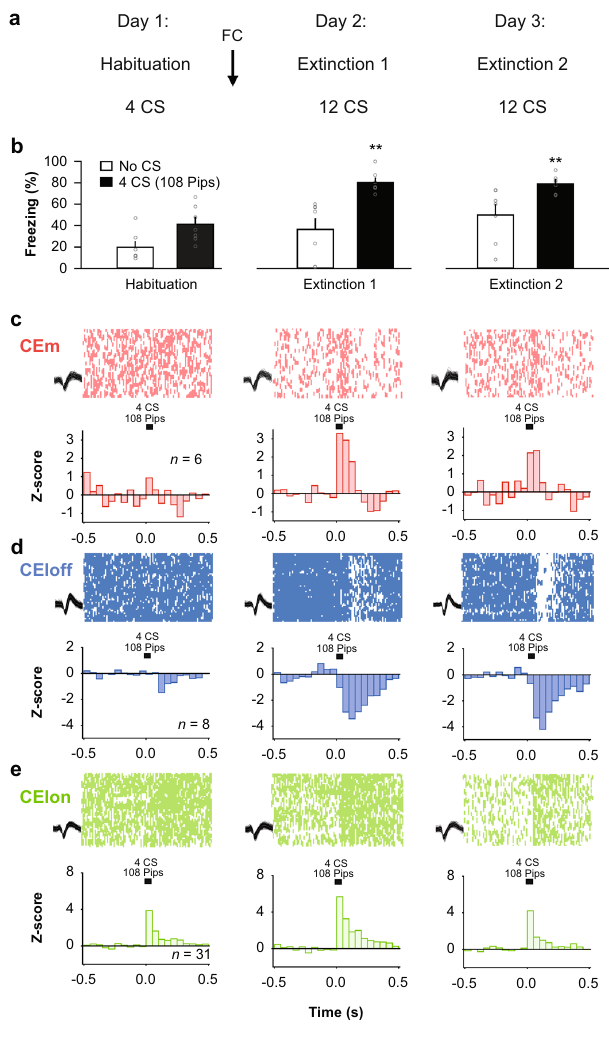
Fig. 4 Impaired extinction correlates with persistent fear-related activity in CEA subpopulations. a Behavioural protocol. FC: fear conditioning. CS: conditioned stimuli. b Behavioural data. S1 mice: n = 7; habituation, no CS: 19.9 ± 5.1%, CS: 41.2 ± 6.3%, beginning of extinction 1, no CS: 36.4 ± 10.1%, CS: 80.3 ± 3.8%, end of extinction 2, no CS: 49.8 ± 9.5%, CS: 78.9 ± 3.2%, blocks of 4 CSs. One-way repeated-measures ANOVA F (5,30) = 12.0, p < 0.001, followed by post hoc Bonferroni t -test vs. CS block during habituation, p < 0.01. Bar plots are expressed as means ± SEM. Circles are freezing values of individual mice. c Raster plots and corresponding spike waveforms of a representative CEm unit (top). Normalized and averaged population peri-stimulus time histograms (bottom). CEm neurons: n = 6 units from 2 mice; z -score, habituation: 0.45± 0.42, beginning of extinction 1: 3.12 ± 0.73, end of extinction 2: 2.21 ± 0.48, blocks of 4 CSs. One-way repeated-measures ANOVA F (2,10) = 5.9, p = 0.020 followed by post hoc Bonferroni t -test vs. during habituation, p < 0.05. d Raster plots and corresponding spike waveforms of a representative CEloff unit (top). Normalized and averaged population peri-stimulus time histograms (bottom). CEloff neurons: n = 8 units from 6 mice; z -score, habituation: − 0.49 ± 0.87, beginning of extinction 1: − 2.46 ± 1.13, end of extinction 2: − 2.73 ± 1.87, blocks of 4 CSs. One-way repeated-measures ANOVA F (2,14) = 4.2, p = 0.037 followed by post hoc Bonferroni t -test vs. during habituation, p < 0.05. e Raster plots and corresponding spike waveforms of a representative CEloff unit (top). Normalized and averaged population peri-stimulus time histograms (bottom). CElon neurons: n = 31 units from 6 mice; z- score, habituation: 1.60 ± 0.38, beginning of extinction 1: 3.09 ± 0.48, end of extinction 2: 1.82 ± 0.46, blocks of 4 CSs. One-way repeated-measures ANOVA F (2,60) = 3.8, p = 0.028 followed by post hoc Bonferroni t -test vs. during habituation, p < 0.05. All individual neurons of each CEA population had signi fi cant z -score values upon CS presentation ( fi rst 4 CSs during extinction 1). Source data are provided as a Source data fi